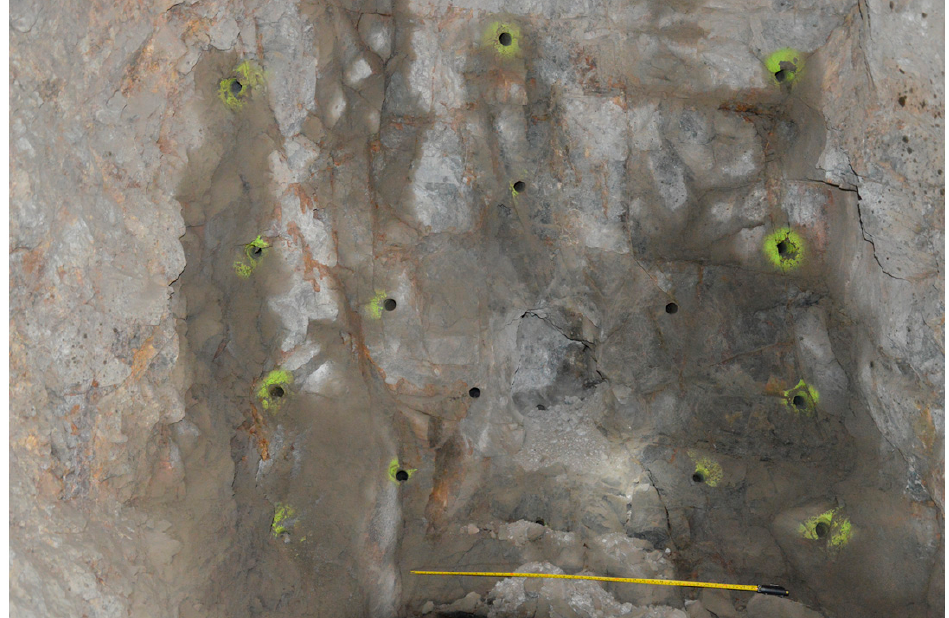
Figure A4. Cavity after detonation of hole with sequence number 3.